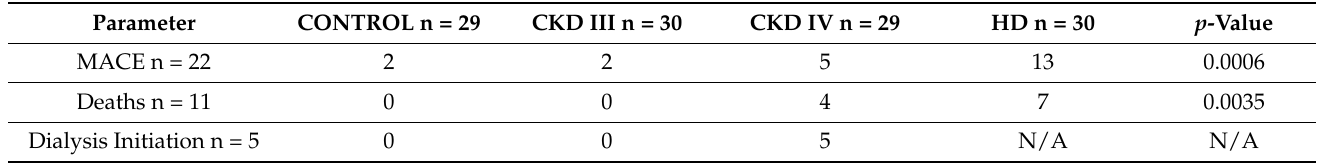
Table 4. Qualitative data on recorded endpoints; data are shown as number of individuals ( p -values derived from Kruskal– Wallis ANOVA analysis).